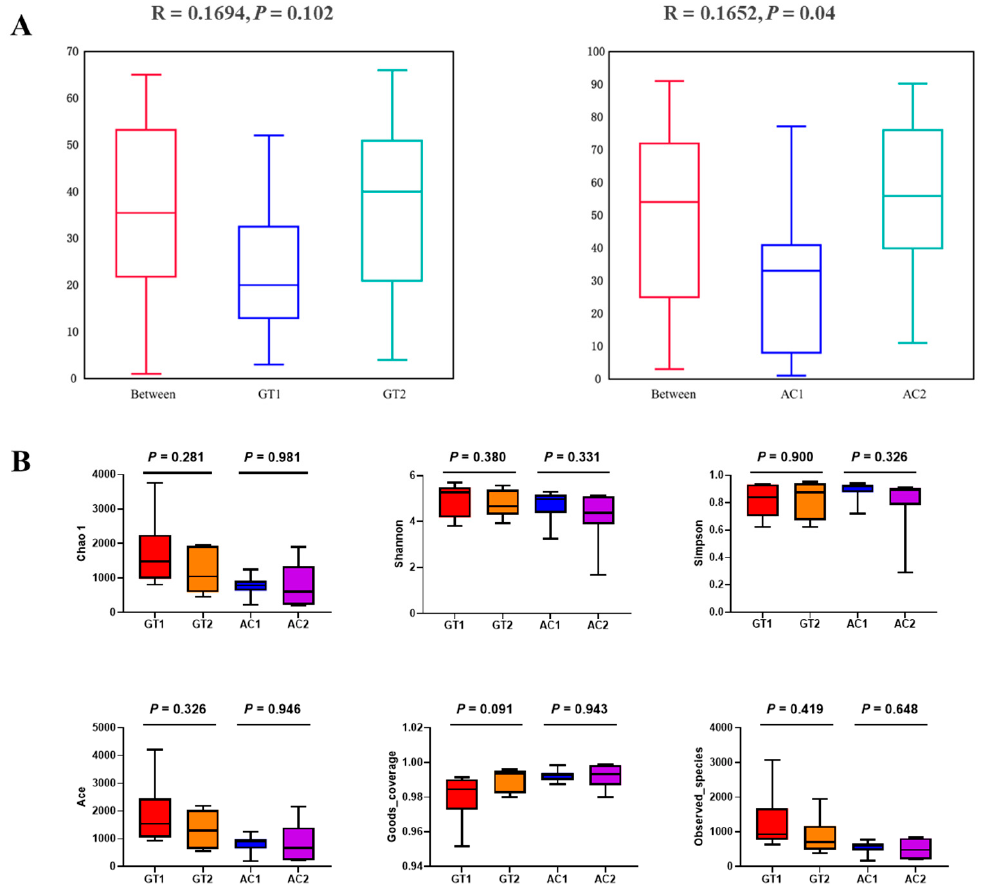
Figure 2. Anosim analysis and α -diversity index analysis of the GT and AC groups. The anosim test box pattern for the GT groups and AC groups ( A ), and the Chao 1, Shannon, Simpson, Ace, Goods_coverages, and Observed_species indices of the GT and AC groups ( B ). Values in ( B ) were analyzed by paired Student’s t -test and are presented as the means ± SE. GT1, before gradual transition, n = 6; GT2, after gradual transition, n = 6; AC1, before abrupt change, n = 7; AC2, after abrupt change, n = 7.